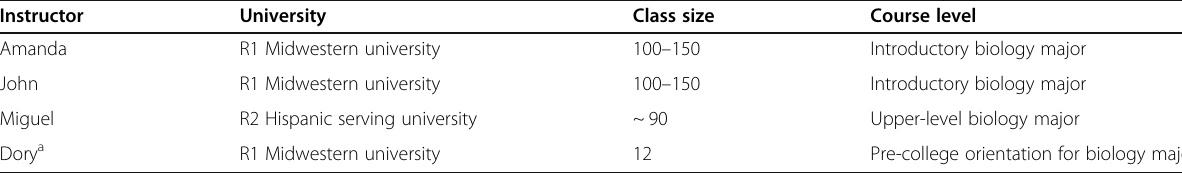
Table 2 Participants and instructional context for each instructor